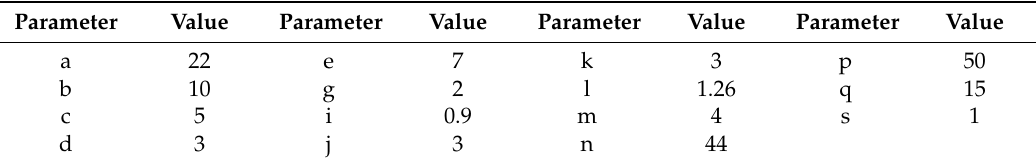
Table 1. Design parameters of our proposed 3D-printed SRR and its outer assembly, which are proposed as a chemical sensor. (Units: mm).